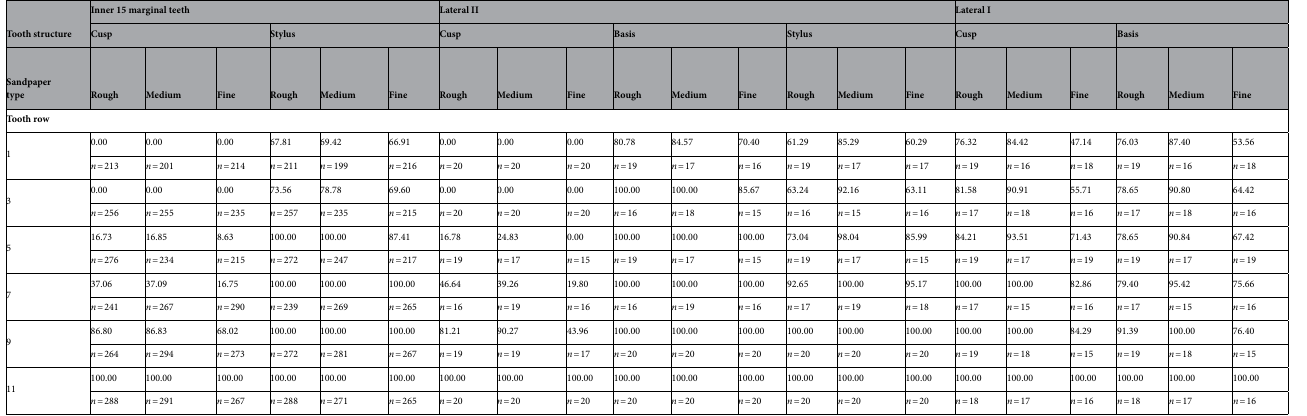
have more and thinner denticles. When all marginal teeth are manually fanned out and unfolded, they make up 43–45% of one transversal row. However, under natural conditions, these teeth rather cluster together and seem agglutinated. The radulae from control group exhibited almost no signs of wear. Only cusps of lateral tooth II leave feeding tracks on the paraffin surface (Fig. 11).